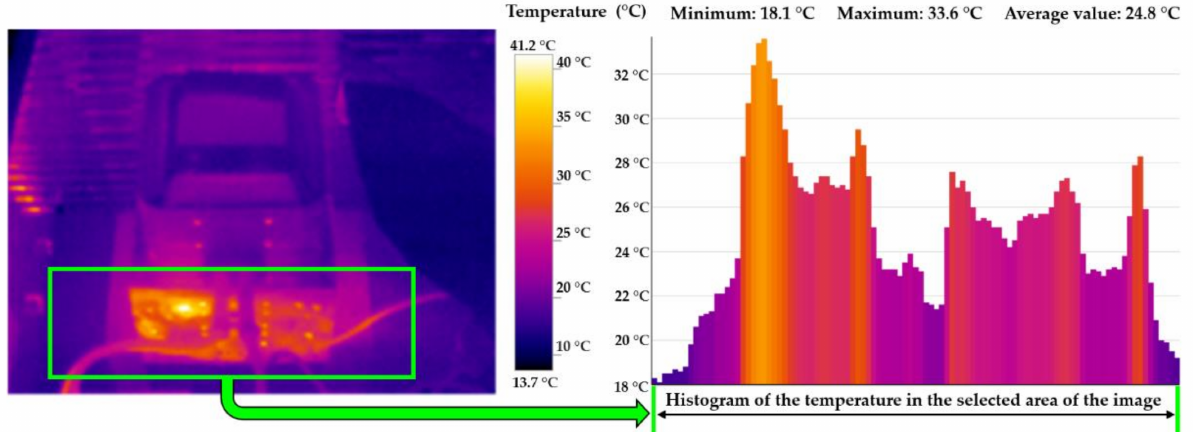
Figure 8. Thermal diagram of a heated magnetron with optimized cooling after 10 min of full power.